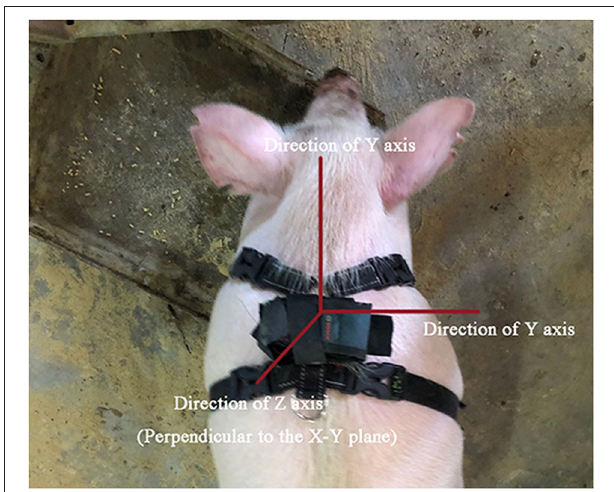
FIGURE 1 | Direction of the back-mounted triaxial accelerometer. The X-axis pointed from the left to the right side of the pig’s body, the Y-axis pointed from the tail to the head of the pig, and the Z-axis was perpendicular to the XY